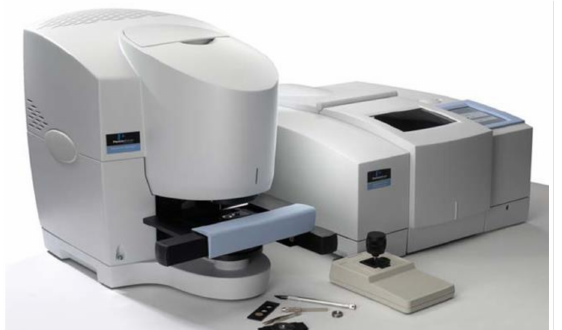
Figure 8. Photo of a commercial Fourier transform infrared (FT-IR) spectrometer equipped with different options for acquisition of spectra in different geometries at micro and macroscopic levels.